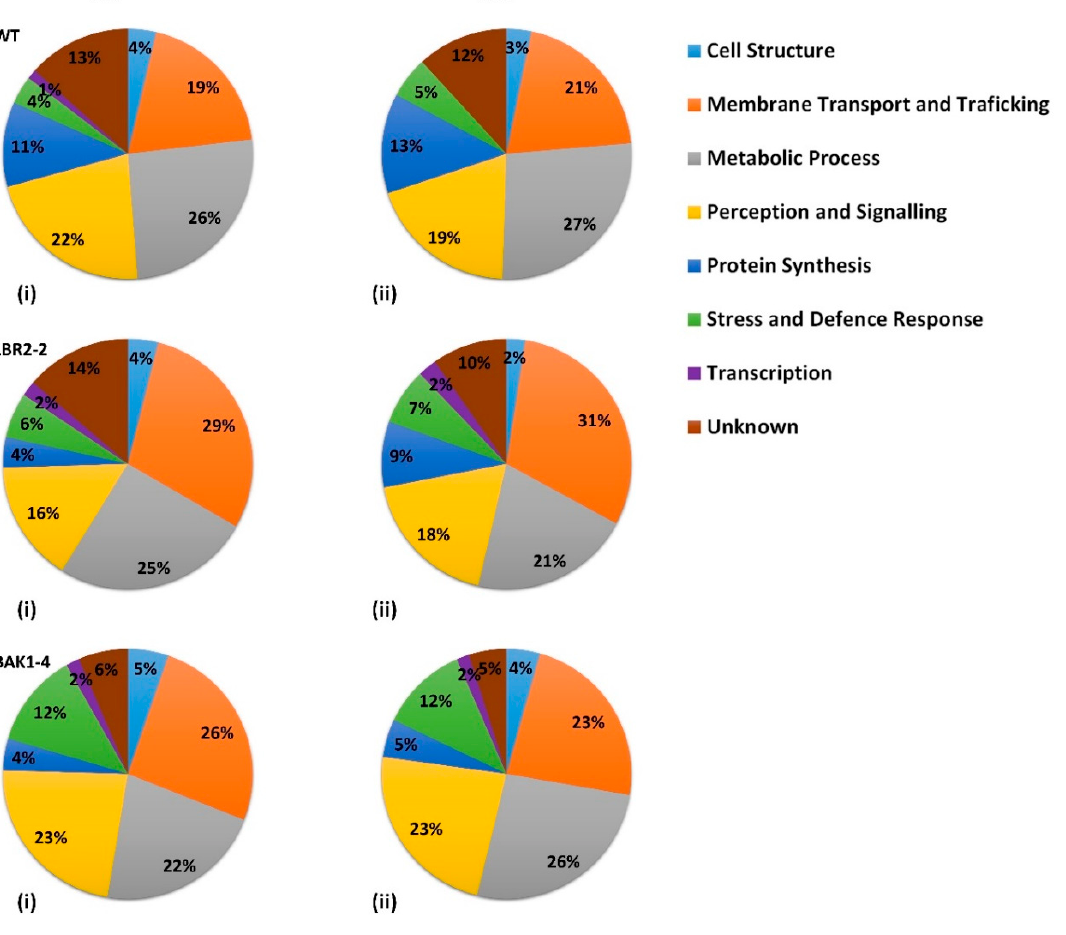
Figure 2. Pie chart comparison of functional categories of PM-associated proteins found to be distinctly associated with the response of the WT and two mutants to the LPS treatments. Proteins that were distinct to WT ( A ), lbr2-2 ( B ) and bak1-4 ( C ) after LPS from Pst ( i ) and Xcc ( ii ) were grouped based on their functional categories.